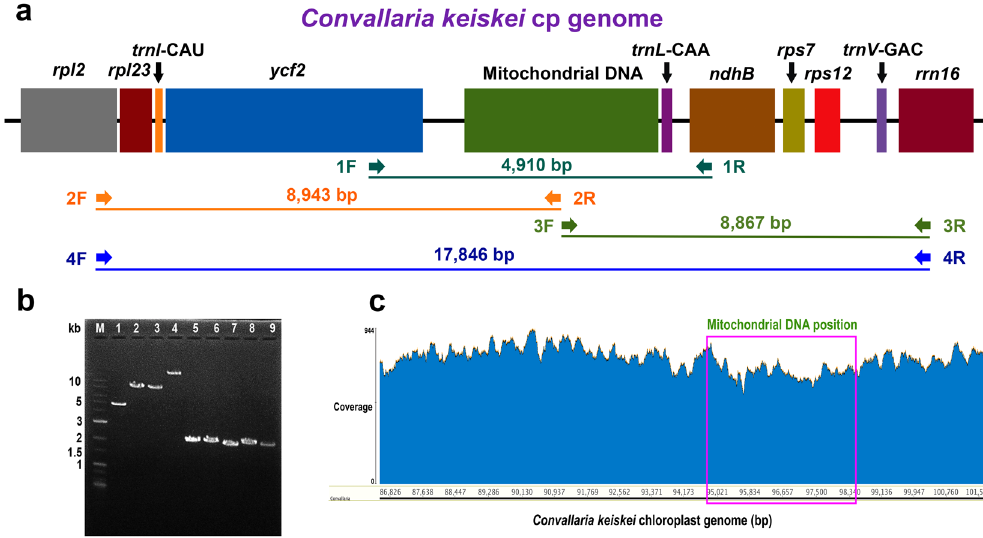
Figure 8. Analysis of mitochondrial DNA transfer in the chloroplast (cp) genome. ( a ) Position of four sets of gene-specific primers in the cp genome of Convallaria keiskei . ( b ) Polymerase chain reaction confirmation of the presence or absence of mitochondrial DNA in the Nolinoideae subfamily cp genome using agarose gel electrophoresis. Lane M: SolGent ™ 1 kb Plus DNA Ladder; Lanes 1–4: C . keiskei cp genome (Lane 1: ycf2 – ndhB , Lane 2: rpl2 mitochondrial DNA region, Lane 3: mitochondrial DNA region– rrn16 , and Lane 4: rpl2 – rrn16 ); Lane 5: Reineckea carnea ; Lane 6: Rohdea japonica ; Lane 7: Tupistra aurantiaca ; Lane 8: Speirantha gardenii ; and Lane 9: Aspidistra spp. ( c ) Sequencing-depth coverage of the mitochondrial DNA insert region (94,989– 98,301 bp) in the C . keiskei cp